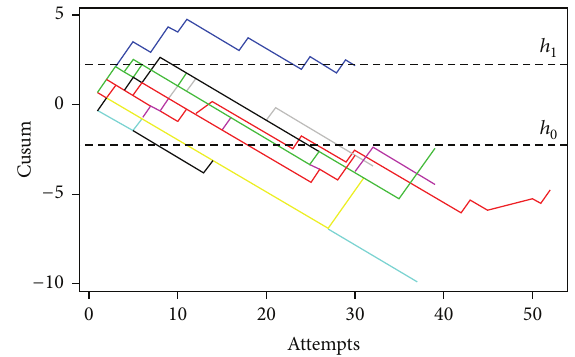
Figure 1: Cumulative sum chart for orotracheal intubation. Each color line and each number represent the learning curves of each nurse anesthetist trainee. Lines ℎ 0 and ℎ 1 represent the upper and lower decision limit of 2.24 and − 2.24,